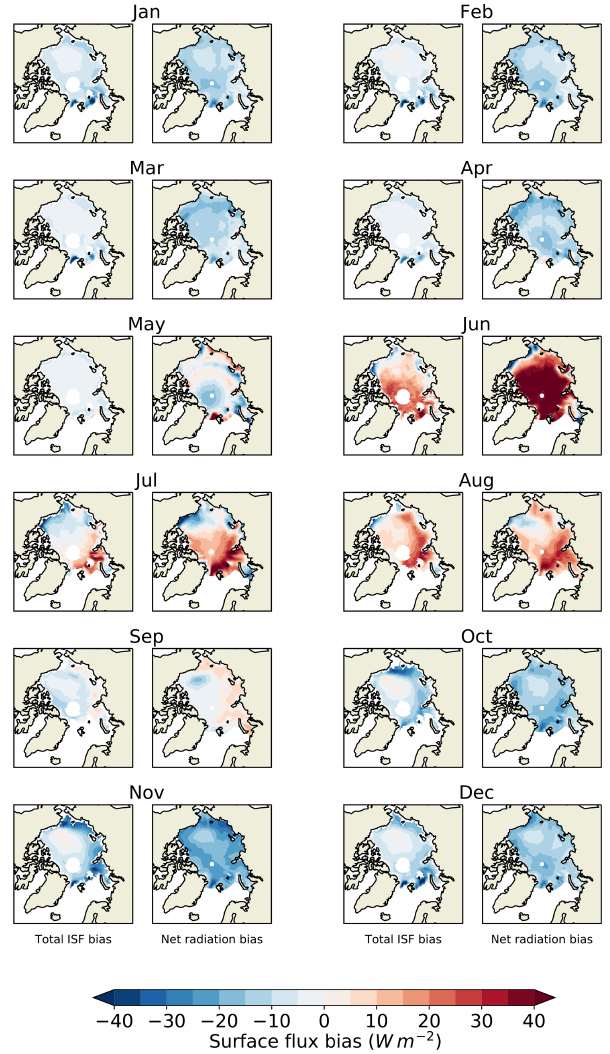
Figure 8. Comparing fields of total ISF bias (left) to net radiation bias (right) relative to CERES for each month of the year for the four historical members of HadGEM2-ES,